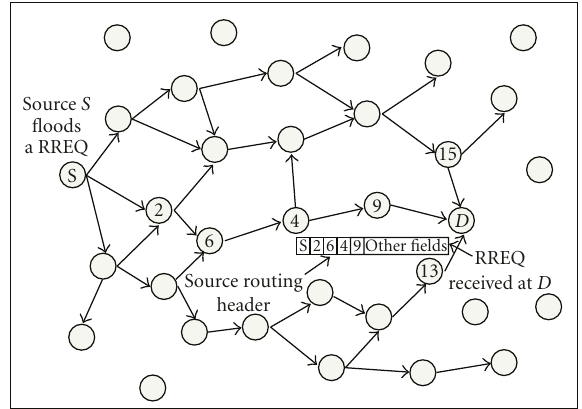
Figure 2: Route discovery in an ad hoc network: source node broadcasts an RREQ which is flooded in the entire